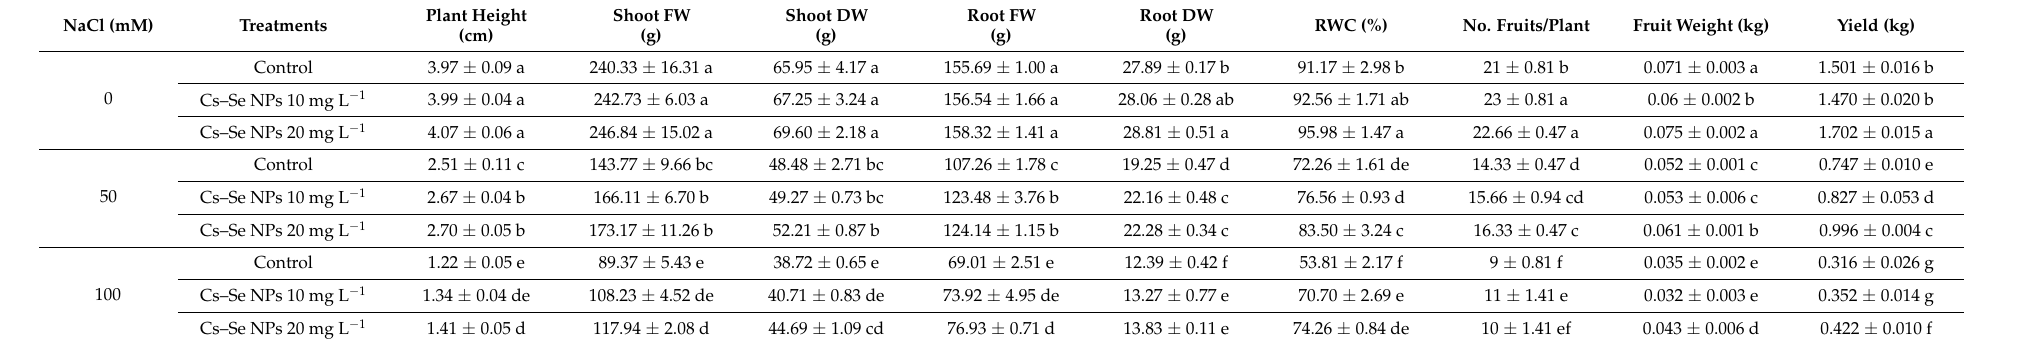
Table 1. Effect of foliar application of Cs–Se NPs (0, 10, and 20 mg L − 1 ) on some morphological parameters of bitter melon ( Momordica charantia ) under salt stress (0, 50 and 100 mM NaCl). Data are the mean of 3 replications (n = 3) ± SD, statistically significant difference is given by letters according to the TMRT ( p <